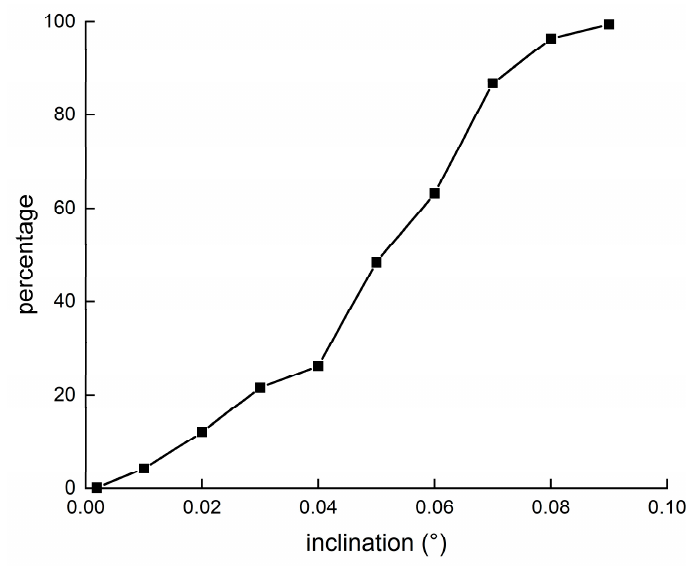
Figure 8. Distribution (percentage) of IOD inclination errors.